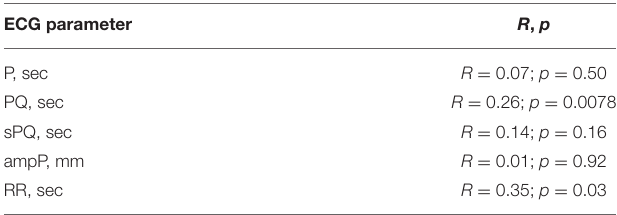
TABLE 2 | Relationship between atrial conduction parameters and age (years) of patients, n = 103. ECG parameter